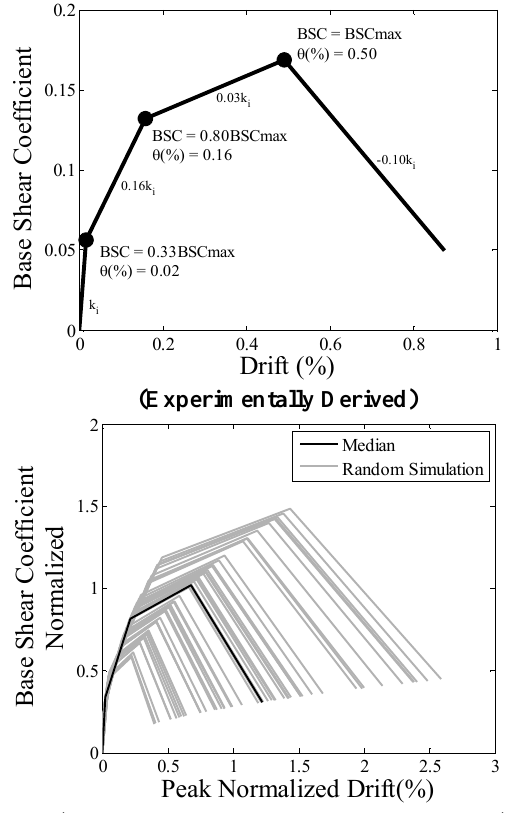
Figure 8 Lateral force-deformation constitutive law of DS masonry structures. From left to right: constitutive law obtained experimentally and randomly generated for SDOF mechanical model. The lateral force in the later case is normalized by the peak lateral strength.